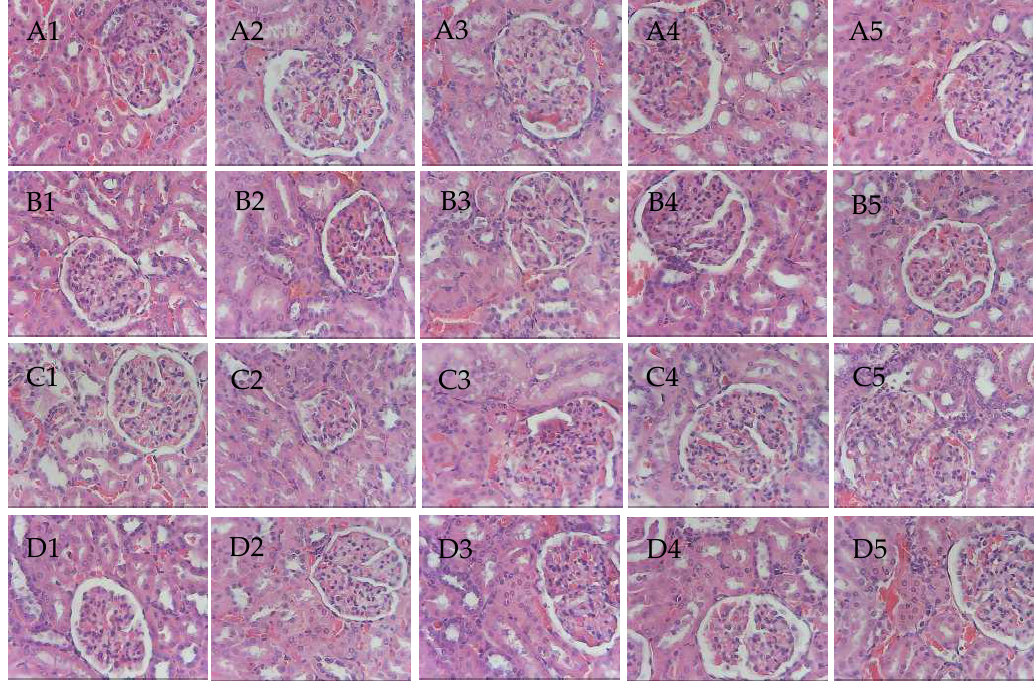
Figure 7. Micropictograph of the kidney tissue sections for( A ) right kidney (magnolol treated group), ( B ) left kidney (magnolol treated group), ( C ) right kidney (mag@Uio-66(Zr) treated group), and ( D ) left kidney (mag@Uio-66(Zr) treated group) (from left to right, rat 1 to 5). Samples were stained with hematoxylin and eosin dyes. Micropictograph was taken at the glomeruli and proximal tubule using 40X objective in OlympusCH2 microscope fitted with a 5MP camera.